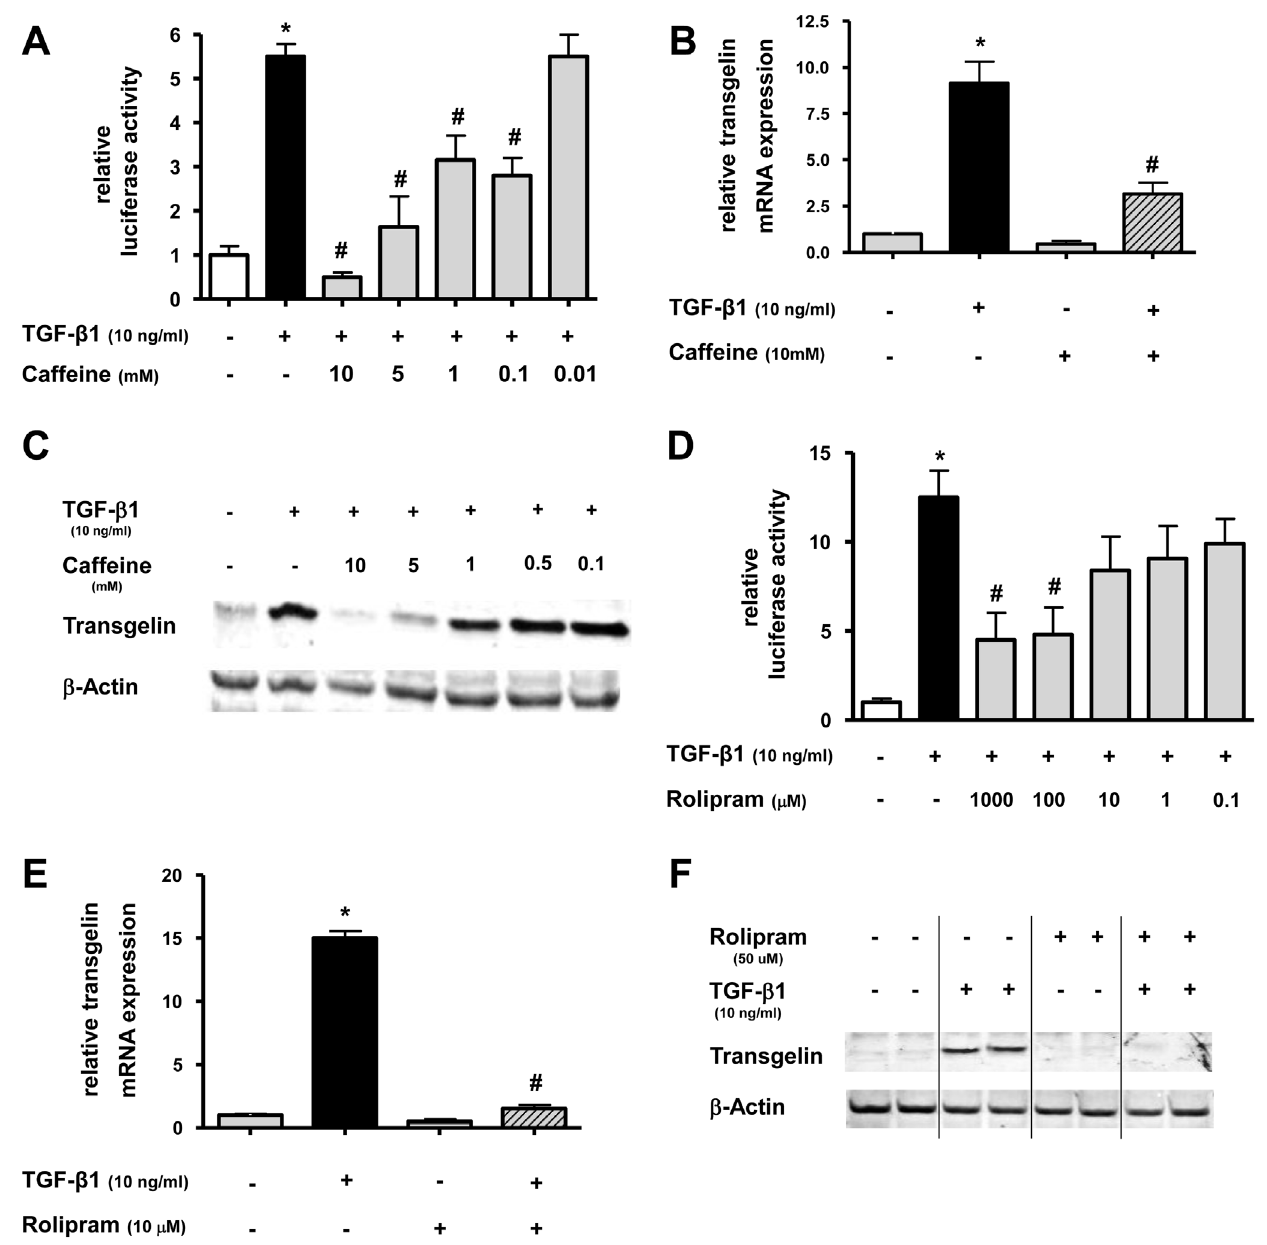
Figure 4. Caffeine and rolipram inhibit TGF- b 1 induced transgelin expression in lung epithelial cells. A + D : The transgelin promoter luciferase construct was transiently transfected into A549 cells. Cells were then treated with TGF- b 1 (10 ng/ml) and/or different concentrations of caffeine (A) or rolipram (D). Firefly luciferase activity was normalized to the activity of Renilla luciferase under control of the thymidine kinase promoter. Relative luciferase activity compared to controls is shown. * p , 0.05 compared to control cells, # p , 0.05 compared to TGF- b 1 treated cells. B + C/E + F : A549 cells were incubated with TGF- b 1 with or without different concentrations of caffeine or rolipram. Realtime PCR of transgelin mRNA was performed after 12 h (B + E) and Western blot analysis after 72 h (C + F). Relative mRNA levels of transgelin were calculated by normalizing signals to detected GAPDH mRNA (B + E) and compared to untreated cells. Means 6 SD of at least n=3 independent experiments are shown. In C + F, representative immunoblots for caffeine (C; triplicates) or rolipram (F; duplicates) against transgelin and b -actin are shown. * p , 0.05 compared to control cells, # p , 0.05 compared to cells treated with TGF- b 1. corresponding scrambled controls. The induction of transgelin To study the functional role of reduced transgelin expression in lung epithelial cells, we generated lentiviral vectors mediating expression of transgelin-specific shRNA. Transduction of A549 cells with those lentiviral vectors resulted in a significant decrease ison to cells expressing non-specific scrambled shRNA (Figure 5B). of basal transgelin mRNA levels (Figure 5A) in comparison to